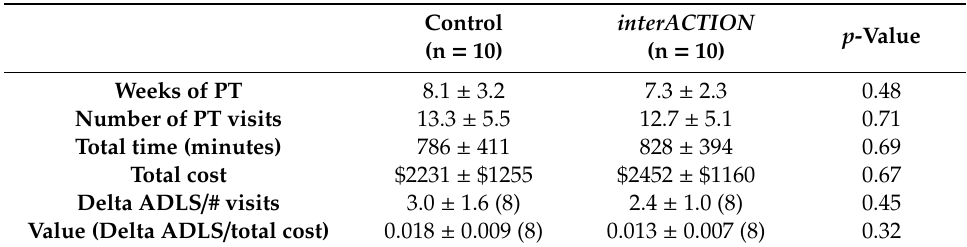
Table 2. Value analysis.